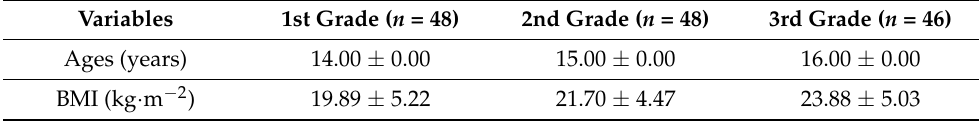
Table 1. Characteristic of participants (Mean ± SD).